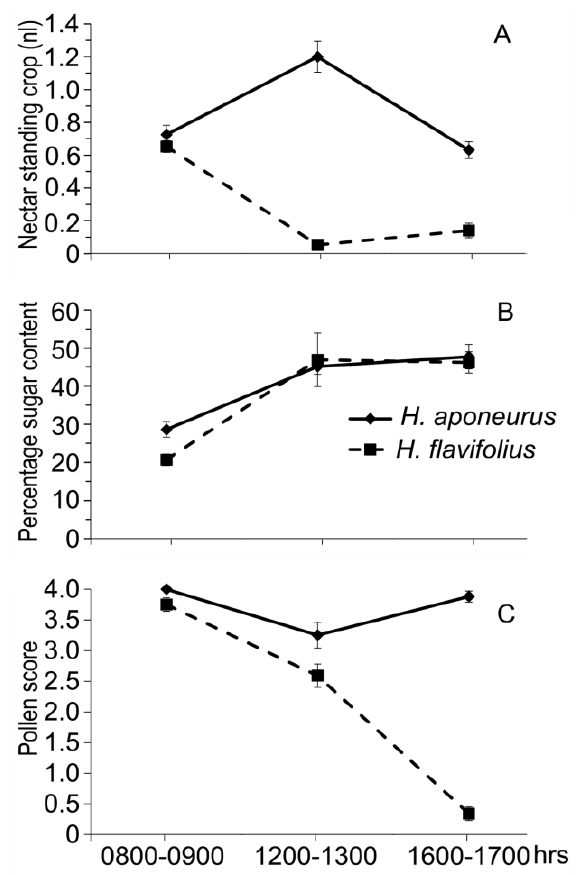
F IGURE 2. Change in floral resources for H. aponeurus and H. flavifolius as recorded in 2005 during three daily time periods at Mpala Research Centre. Graphs show A) nectar standing crop ( μ L / flower); B) nectar sugar concentration (% sugar); and C) pollen availability (as pollen score). Data points are grand means ± S.E. across all flowers (25 - 49 per species) and sampling dates (2 days for H. aponeurus and 3 days for H. flavifolius). The percentage of pollen remaining in anthers was scored on a scale of 0 - 4 (0 = < 1%; 1 = 1 - 25%; 2 = 26 - 50%; 3 = 51 - 75%; 4 = 76 - 100%).